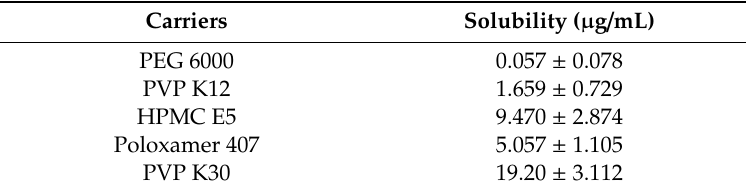
Table 1. Apparent aqueous solubility of LW6 in solid dispersions (SDs) with di ff erent polymers. Data are expressed as the mean ± standard deviation (n = 3). PEG: polyethylene glycol, PVP: povidone, HPMC: Hydroxypropyl methyl